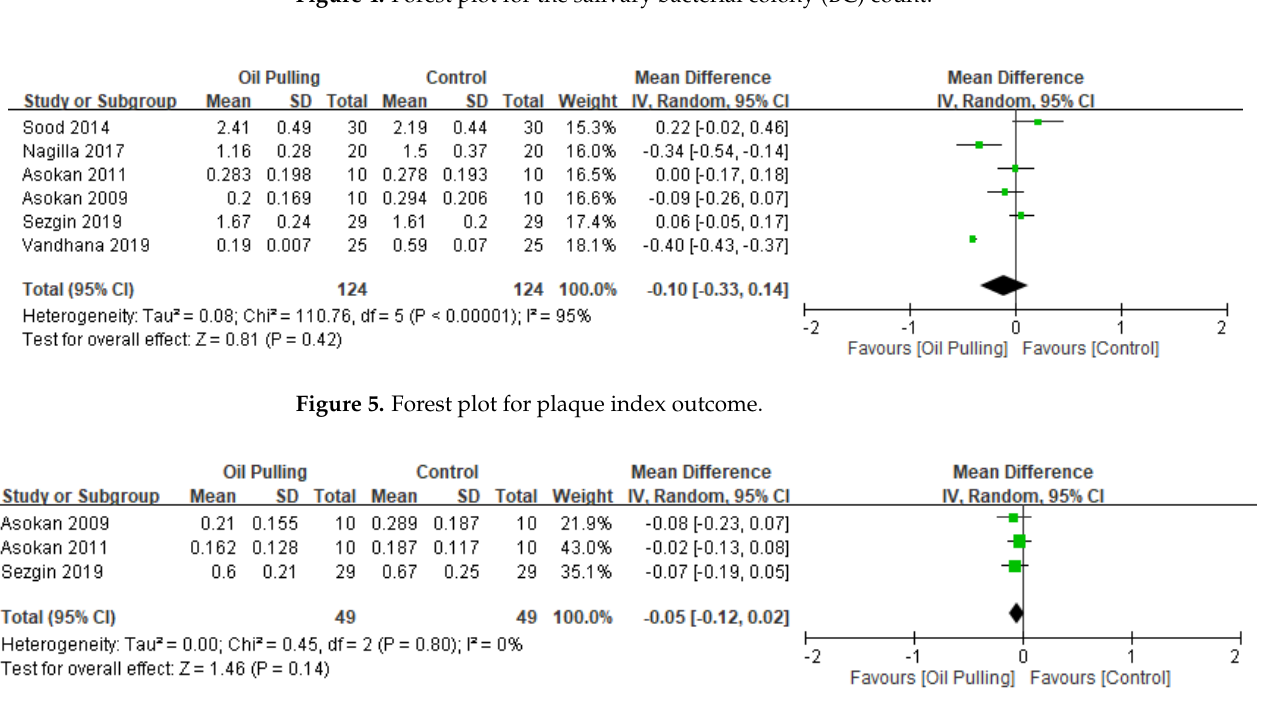
Figure 6. Forest plot for gingival index outcome.